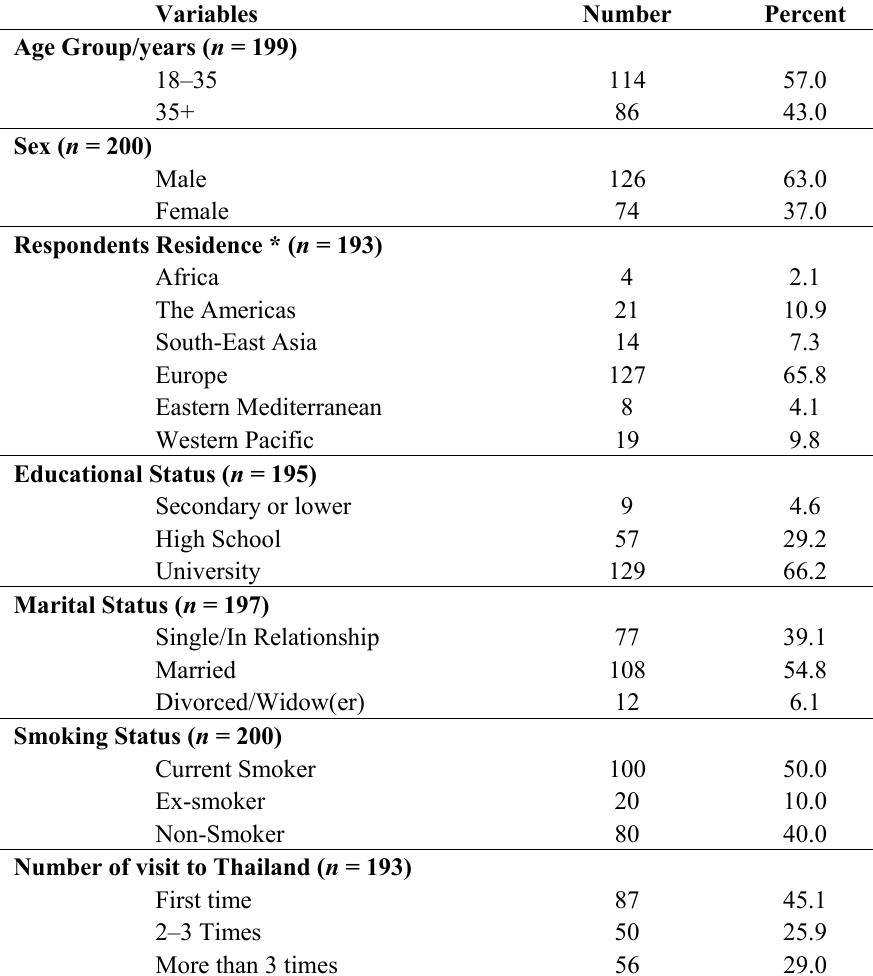
Table 1. General Characteristics of